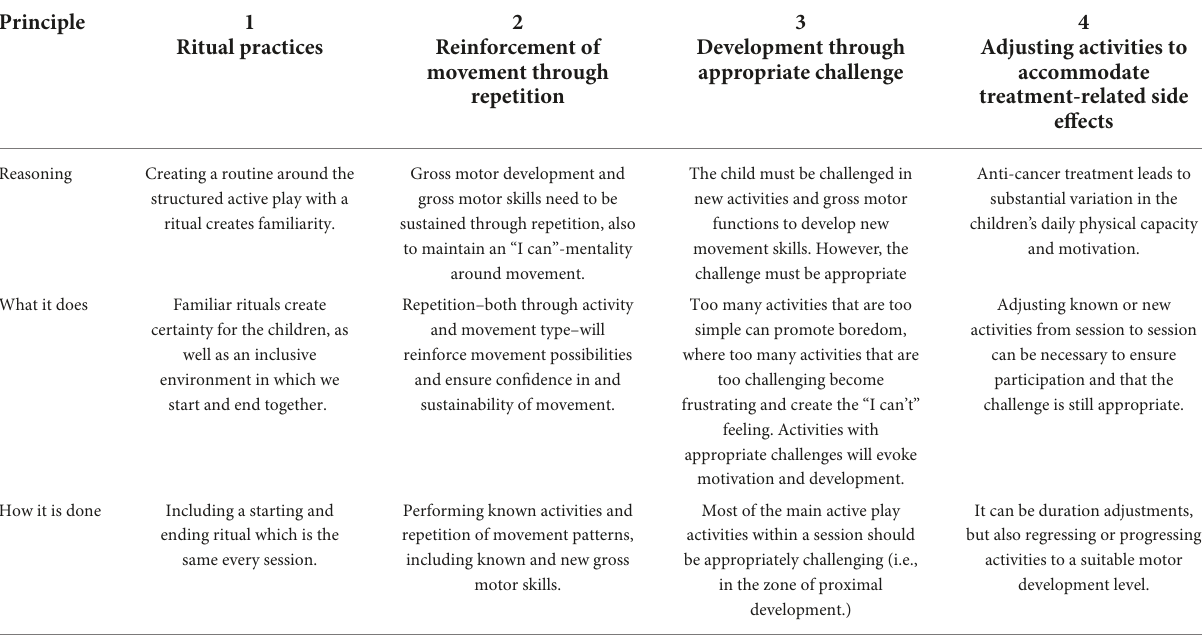
TABLE 1 A summary of the four core